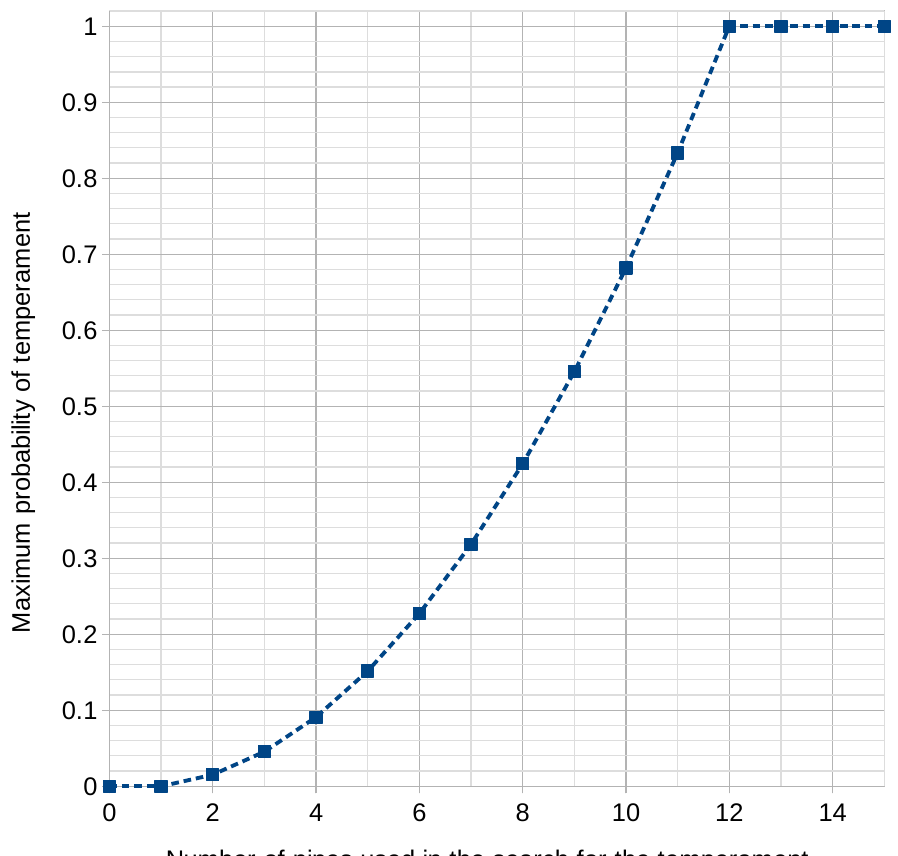
Figure 6. The maximum probability of finding the temperament relative to the number of pipes used in the search for the required